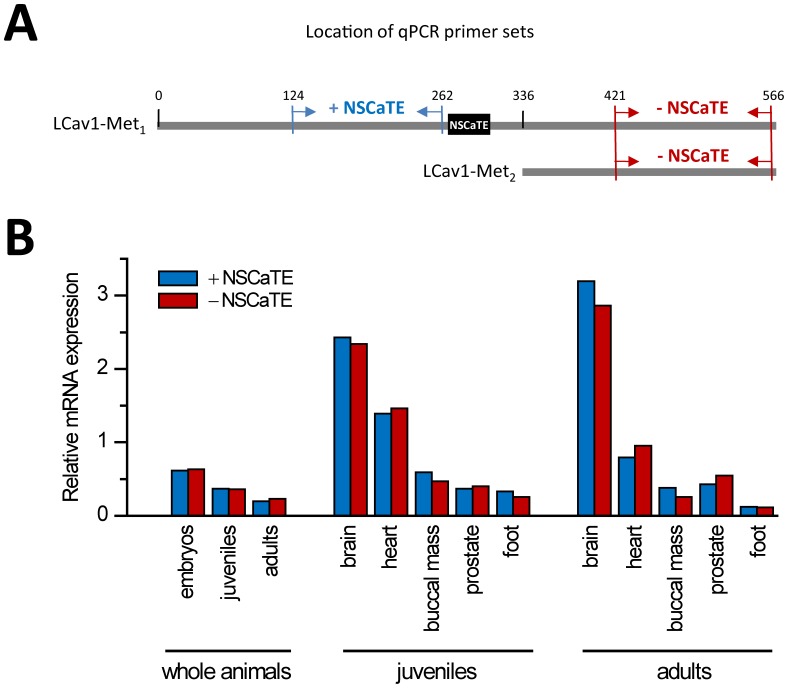
No difference in levels between snail LCav1 (L-type) channel mRNA transcripts containing NSCaTE (LCav1-Met1) and those lacking NSCaTE (LCav1-Met2).A) Illustration of the location of primer sets for qPCR amplification of snail mRNA transcripts containing or lacking NSCaTE in LCav1 channels. Numbers refer to the position of the DNA sequence from LCav1-Met1 translational start site. B) Graph illustrates the lack of significant difference in mRNA expression levels (relative to HPRT control values, scaled such that the sum of all signal values across tissues are equal) in whole animals or in specific tissues of snails containing or lacking the LCav1NSCaTE sequence. Degree of correlation with adjusted R2 value = 0.95.